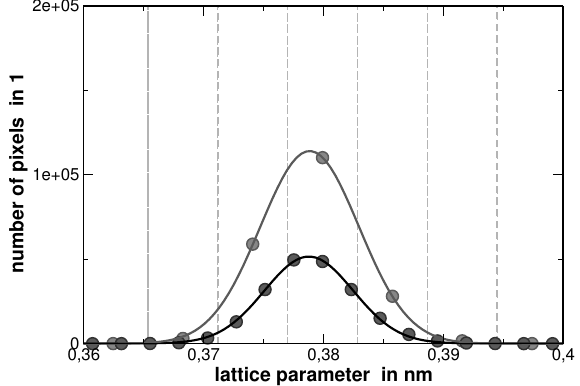
Figure 6. Distribution of the lattice parameters in the segregated sample calculated from the EDX mappings with equidistant separation into 7 and 17 fractions, respectively. The dashed lines in the background indicate the borders corresponding to the separation into 7